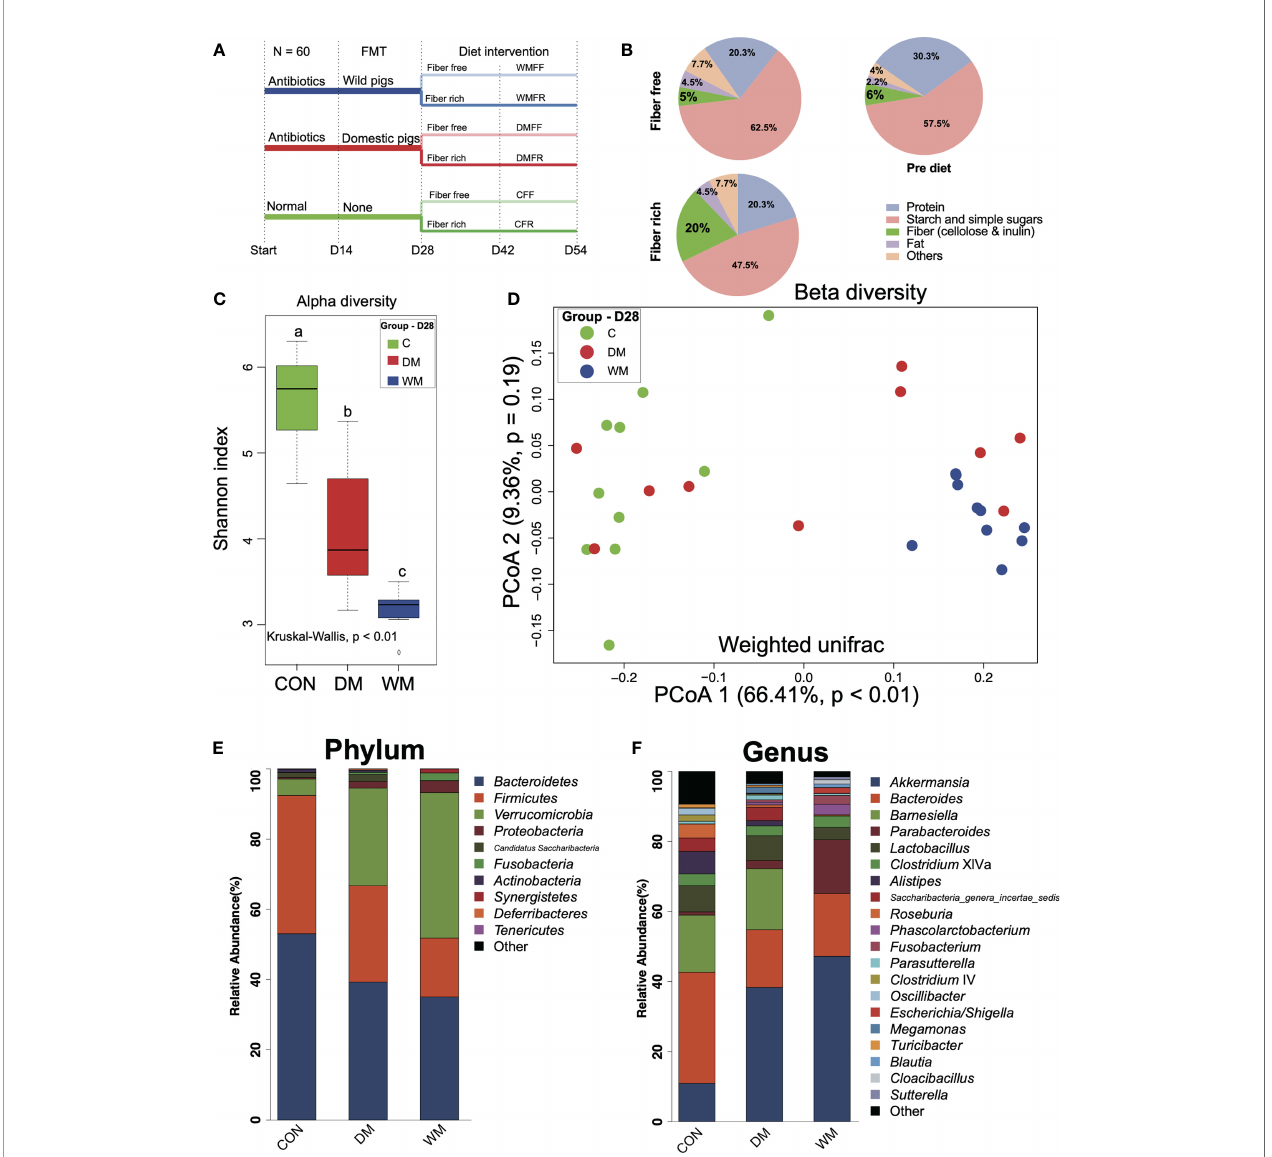
FIGURE 1 | Timeline of trial schematic, diet composition, and bacteria patterns of mice after fecal microbiota transplantation (FMT). (A) Schematic of the mouse model illustrating the timeline of antibiotic treatment, fecal microbiota transplantation (FMT), feeding strategies, and fecal sampling. (B) Composition of the diets employed in this study. (C) Shannon index of the control group (CON), mice FMT with domestic pigs (DM), and wild pigs (WM). (D) Principal coordinates analysis (PCoA) of gut microbiota structures in the mice of the CON, DM, and WM groups. (E, F) Bar plot of phylum and genus levels in the mice of CON, DM, and WM groups. Kruskal – Wallis test with an adjusted p- value of <0.05 was applied. a,b,c Means within the same row followed by different superscripts differ at p <